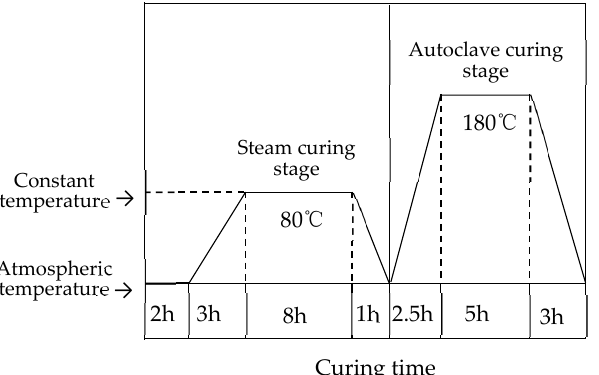
Figure 1. Steam curing and autoclaved curing.